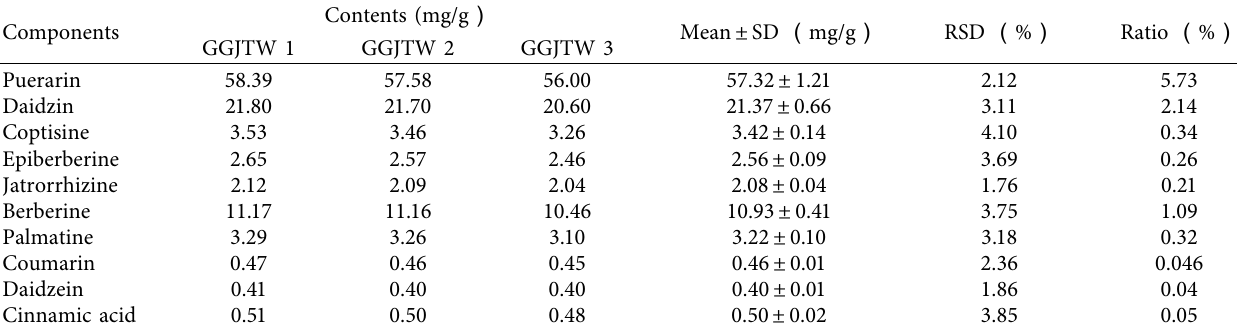
Table 3: Content determination of 10 components in GGJTW (n �